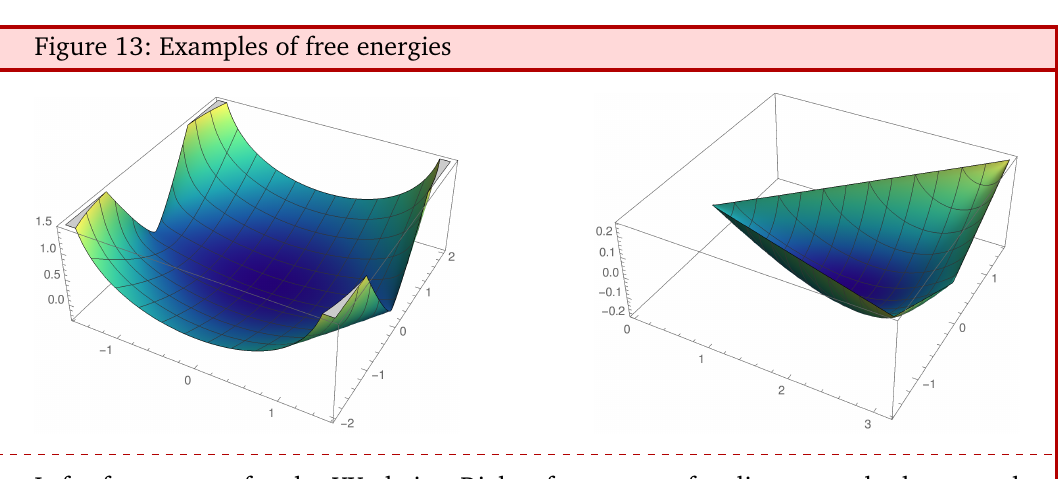
Left: free energy for the XX chain. Right: free energy for dimers on the hexagonal lattice, shown as a function of k , s , for u = 3 / F